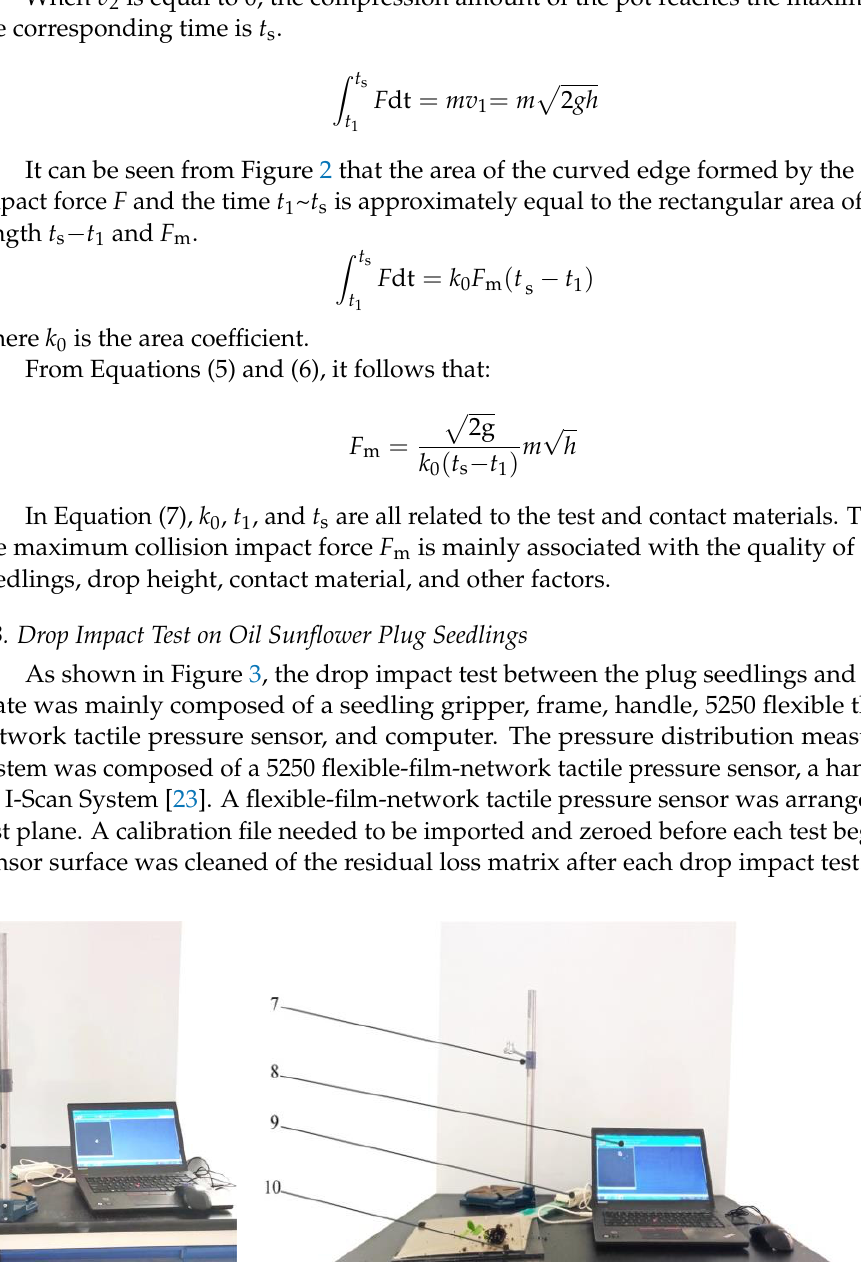
Figure 4. Position of the plug seedlings with steel plates before dropping. Table 1. Properties of three contact materials. Type of Material Thickness/mm